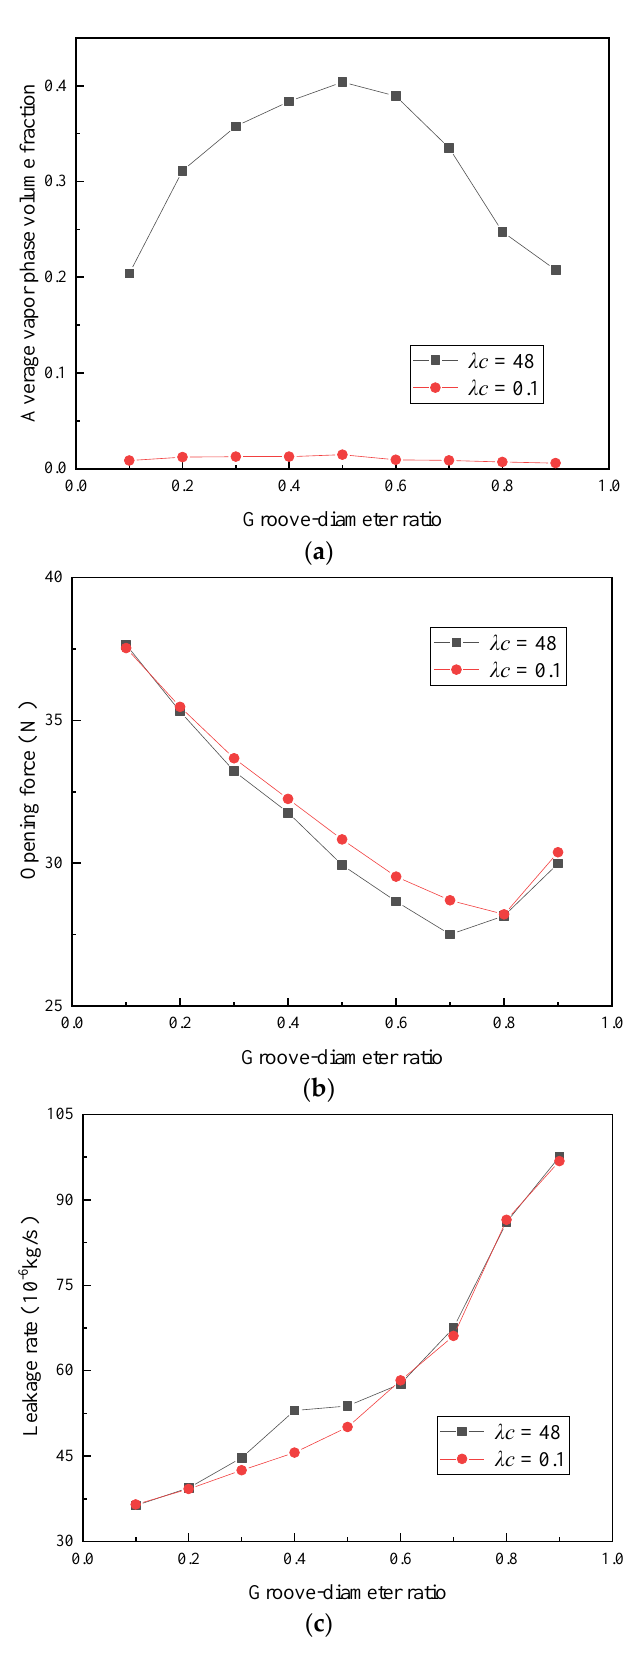
Figure 6. Effect of groove-diameter ratio on sealing performance. ( a ) Effect on the average vapor phase volume fraction. ( b ) Effect on the opening force. ( c ) Effect on leakage rate. When λ c = 0.1, the average vapor phase volume fraction, opening force, and leakage rate are almost equal to the groove-diameter ratio. However, the average vapor phase